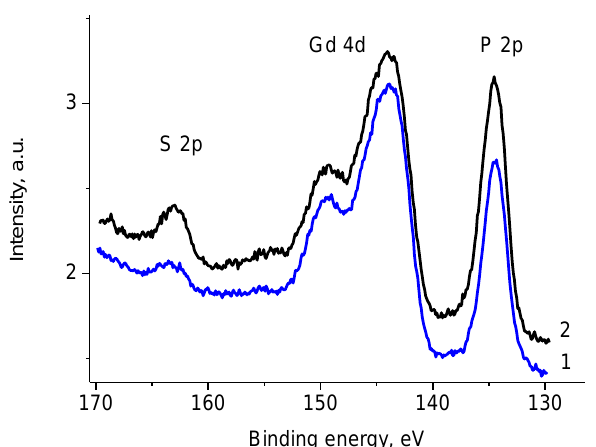
Figure 23. The S 2p, Gd 4d, and P 2p photoelectron spectra of sample Pt/1′ recorded using Al Kα (1) and Mg Kα (2) radiations.